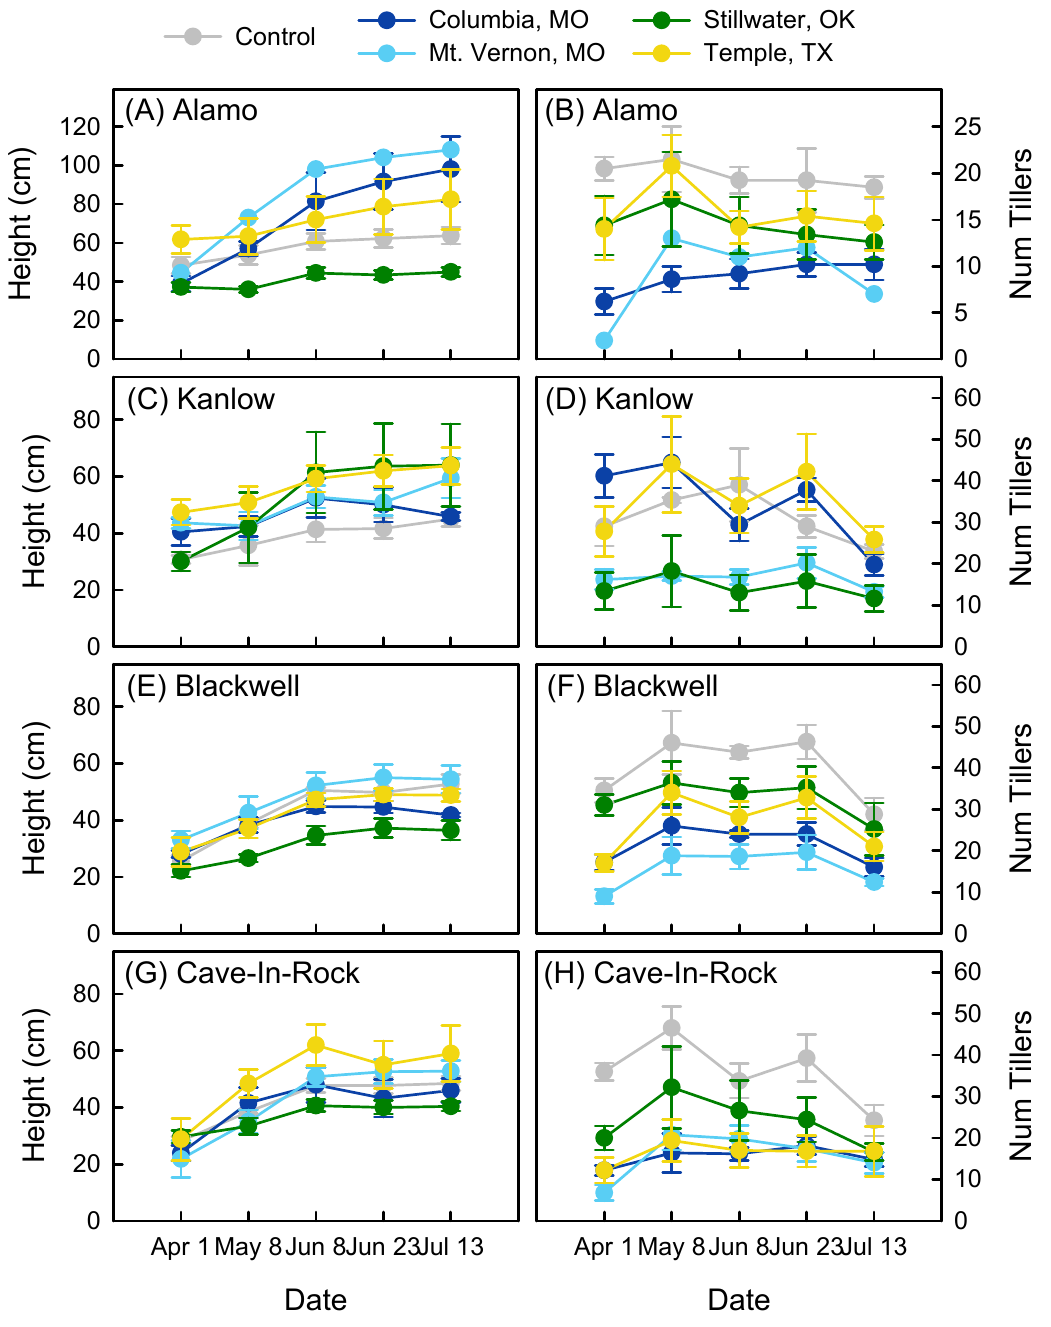
Figure 1. Height (left) and number of tillers (right) for switchgrass cultivars ( A – H ) and soil inoculum sources (colors) across five dates from April to July 2015. Note the di ff erent scales for Alamo ( A , B ) compared to all other ecotypes ( C – H ). Points are means ± SE ( n =